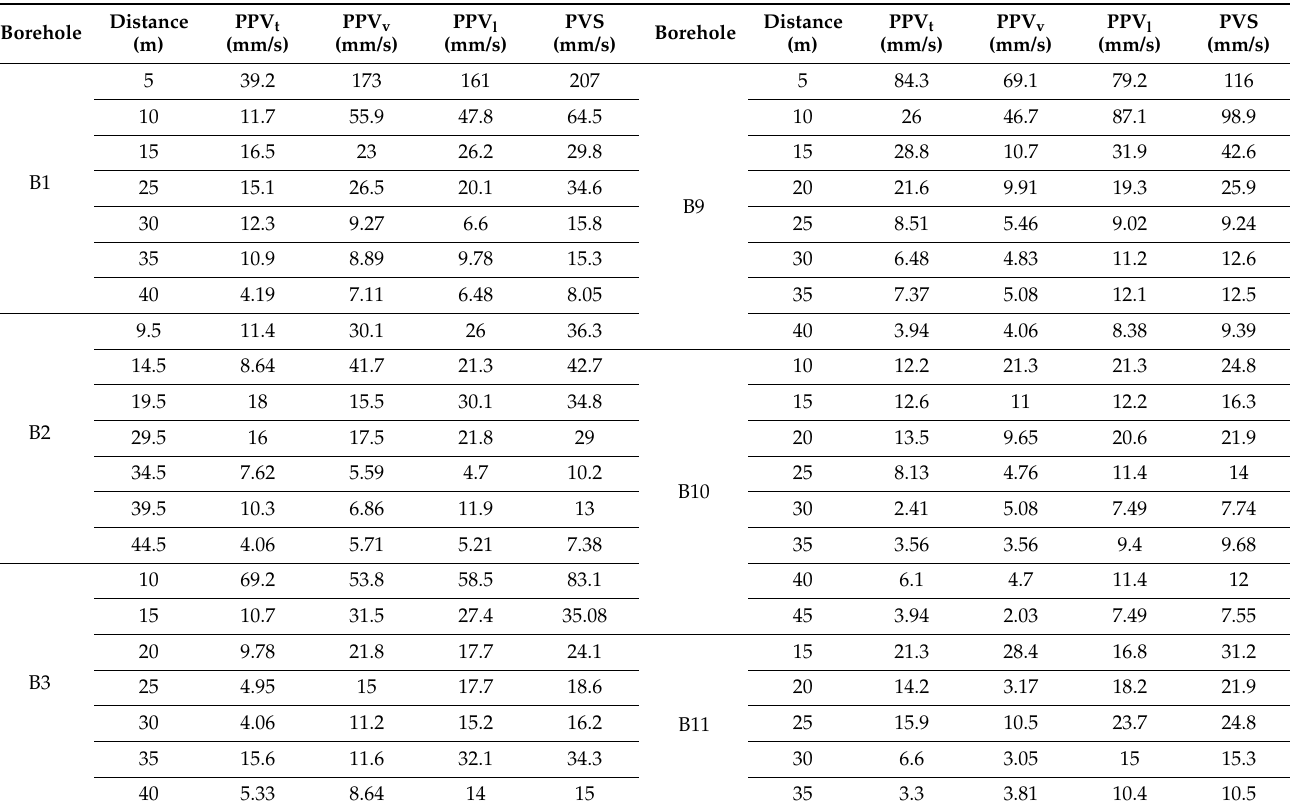
Table 1. The measurement data of the blast-induced seismic effects for all 17 boreholes.